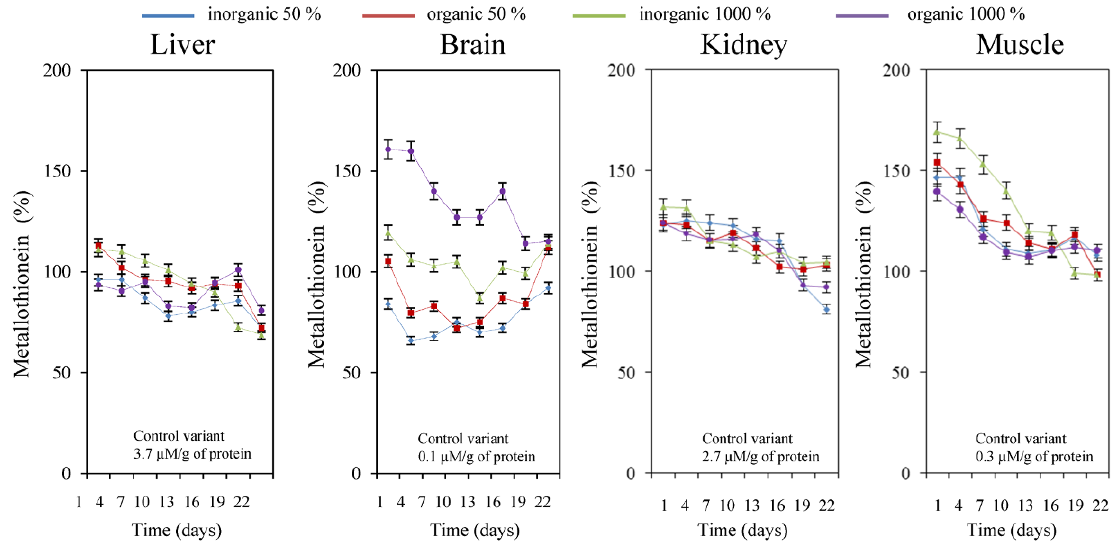
Figure 4. Metallothionein (MT) level in the examined organs. The level was related to the controls. Error bars indicate standard error of mean for three specimens. Metallothionein was determined using differential pulse voltammetry Brdicka reaction. The MT results were related to a control group and recalculated as a percentage of control. Control group was determined as a one hundred percent from individual values as follows: liver 3.7 μM, brain 0.1 μM, kidney 2.7 μM and muscle 0.3